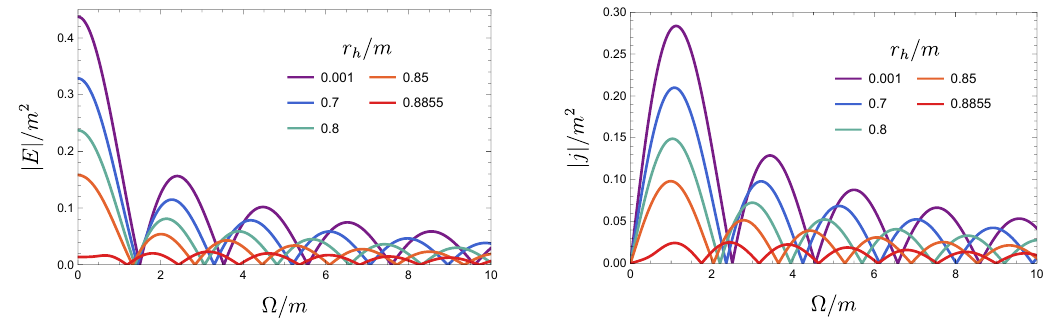
Figure 3 . Electric field and current of the critical embeddings versus driving frequency, for different values of r h in D3/D5. The frequencies for which | E | vanishes are the critical frequencies Ω c of the vector meson Floquet condensates. The regions of black hole embeddings between lobes, above such critical points, are termed wedges in the text. In the right plot we show the value of the current along the curve of critical embeddings. We observe points with | j | = 0 somewhere close to the maxima of the lobes in the left plot. We will term these points Floquet suppression points , and will study them in detail in section